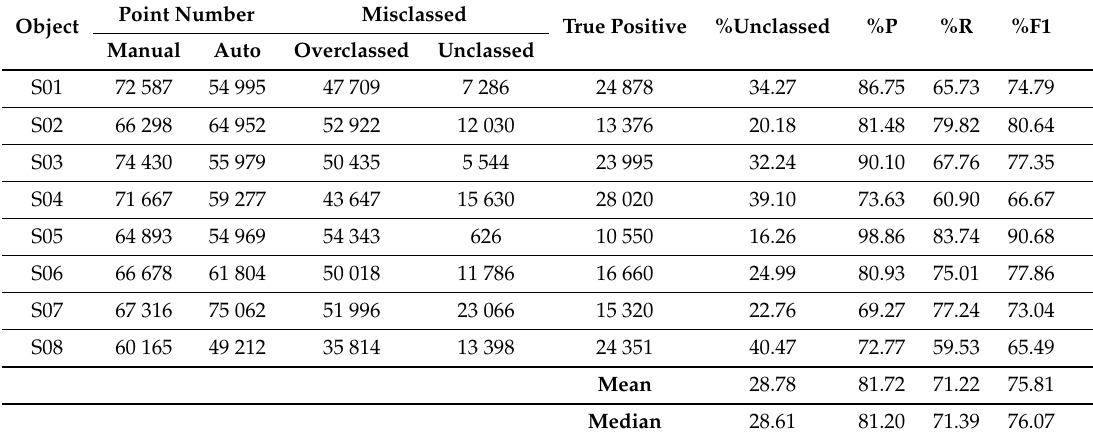
Table 5. Quantitative analysis on the results of step 2 for the detection and classification of columns in the St-Pierre dataset. %P is precision, %R is recall, and %F1 is the normalized F1